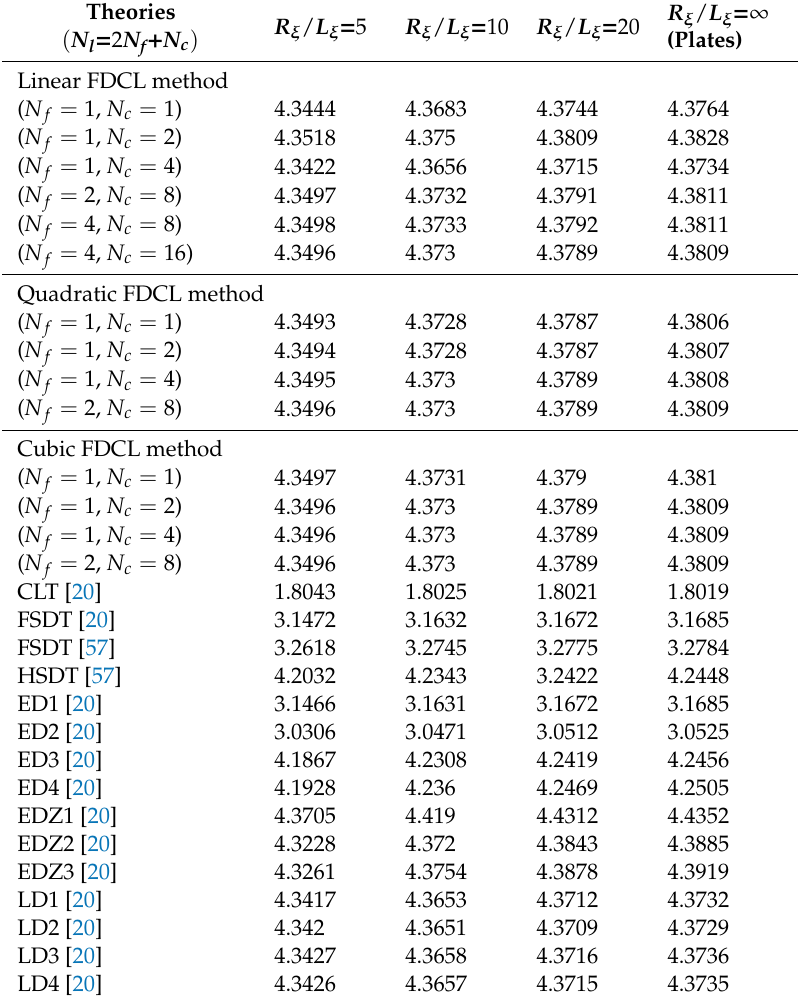
Table 1. Results of convergence and accuracy studies for the dimensionless deflections induced in thick sandwiched spherical shells ([0 ◦ / core / 0 ◦ ]) under a thermal